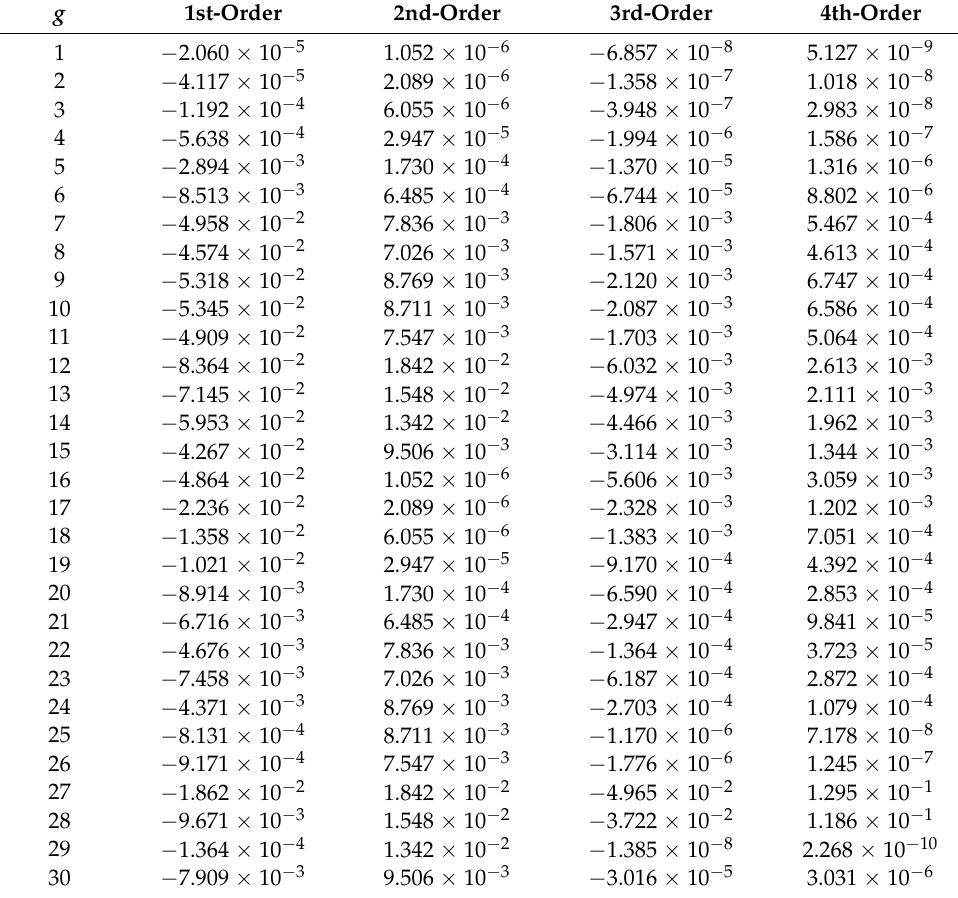
Table 3. Comparison of the 1st-order, 2nd-order, 3rd-order and 4th-order unmixed relative sensitivi- ties S ( 1 ) 2 ( 240